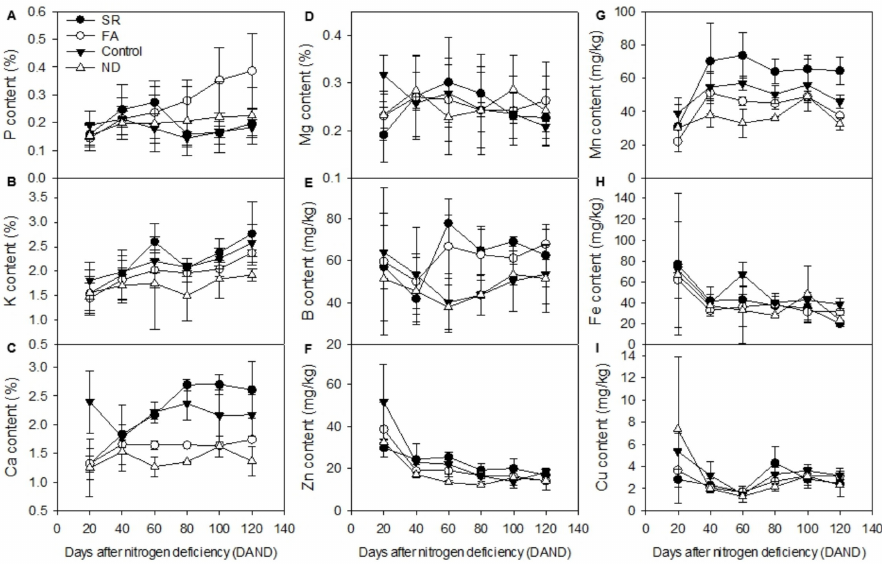
Figure 3. Changes in mineral nutrient concentrations in leaves of ‘Shiranuh’ according to N deficiency and resupply: P ( A ), K ( B ), Ca ( C ), Mg ( D ), B ( E ), Zn ( F ), Mn ( G ), Fe ( H ) and Cu ( I )